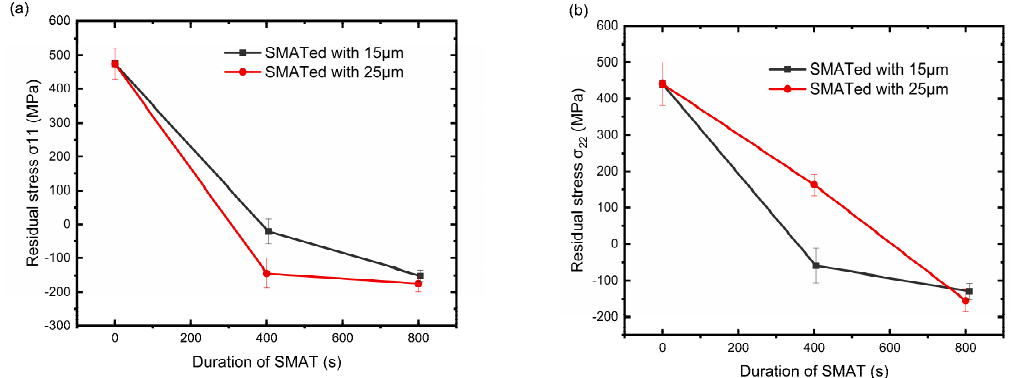
Figure 10. Residual stress evolution of Ni–Cr coatings as a function of SMAT duration: ( a ) σ 11 ; ( b ) σ 22 .